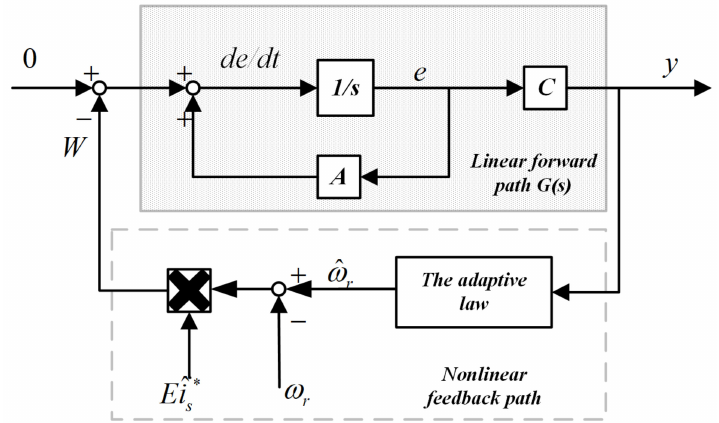
Figure 6. Block diagram of the error system